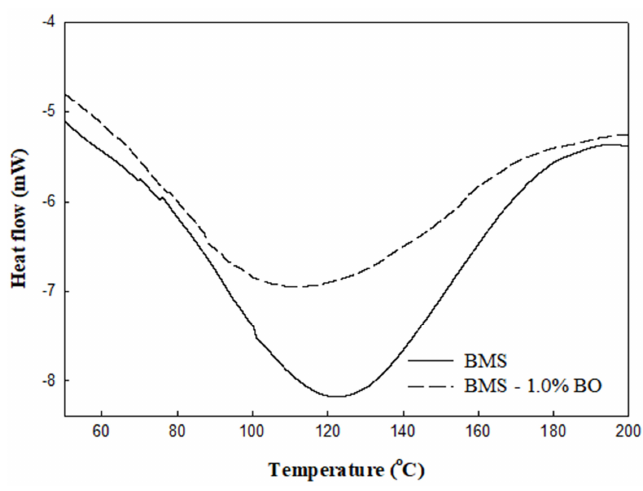
Figure 3. DSC curves of the BMS films containing BO.